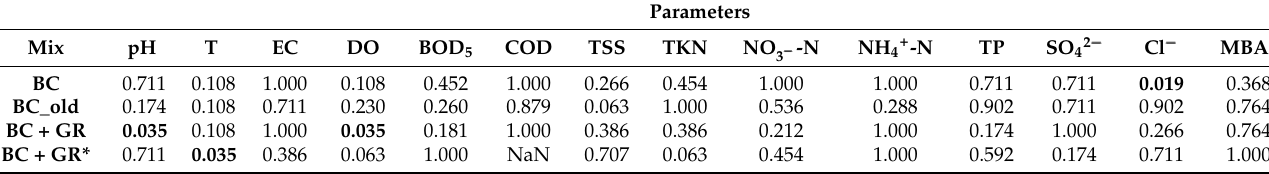
Table 4. p -values of Mann-Kendall test on on-site parameters measurements and laboratory parameter removal efficiency. Bold numbers indicate an increasing trend ( p < 0.05) in the temporal series; asterisks confirm the trend after false discovery rate adjustment. NaN occurs when all values in a data set are below the detection